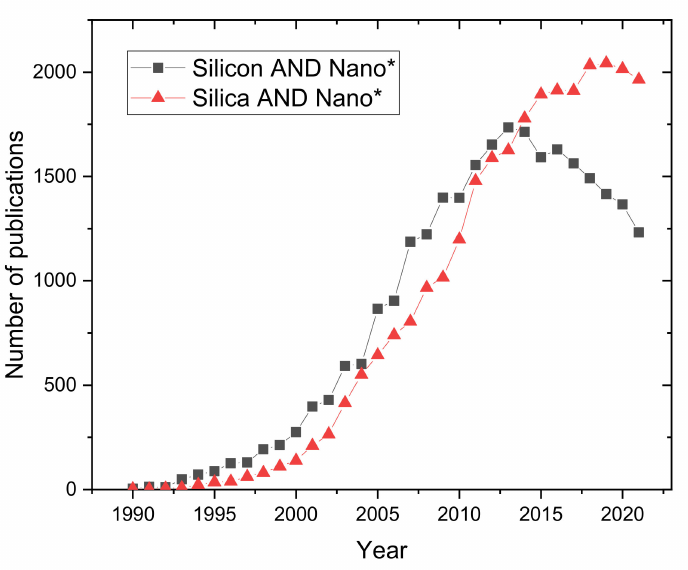
Figure 1. Number of articles published per year about silicon or silica nanostructures, based on a search using the keywords “Silicon AND Nano*” or “Silica AND Nano*” on the website Web of Science. The star * at the end of nano means that all words beginning with “nano” are considered in the search (nanoparticles, nanowires . . .